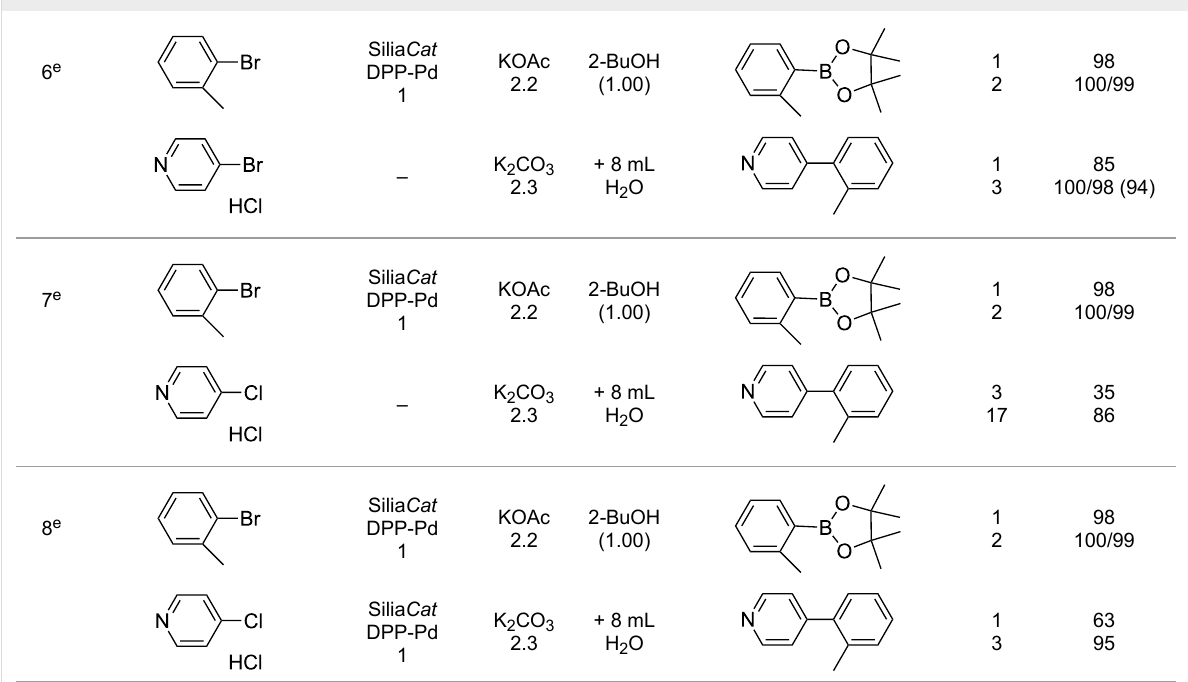
Table 1: One-Pot Silia Cat DPP-Pd-catalysed borylation a and Suzuki–Miyaura coupling b reactions.